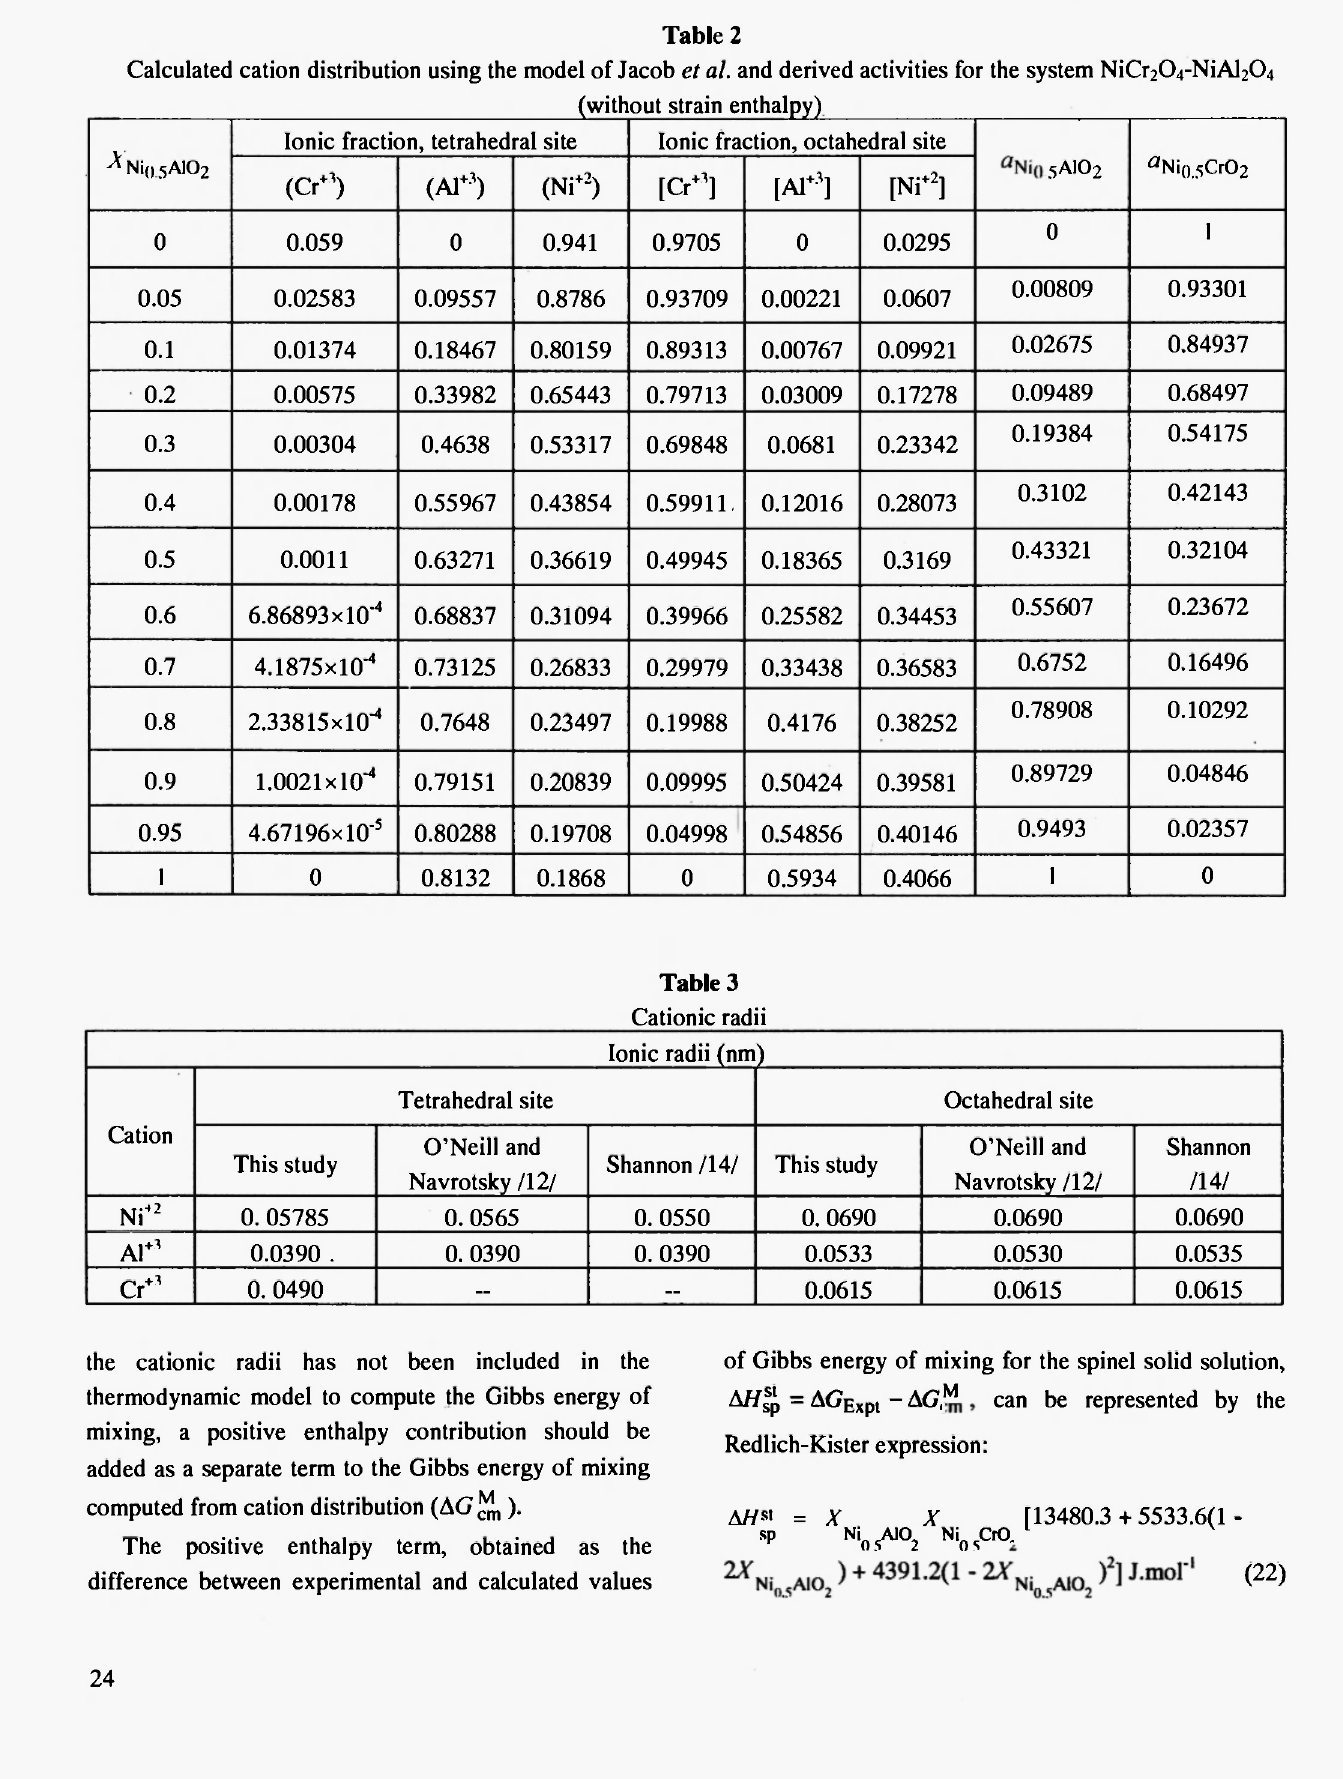
Calculated cation distribution using the model of Jacob et al. and derived activities for the system